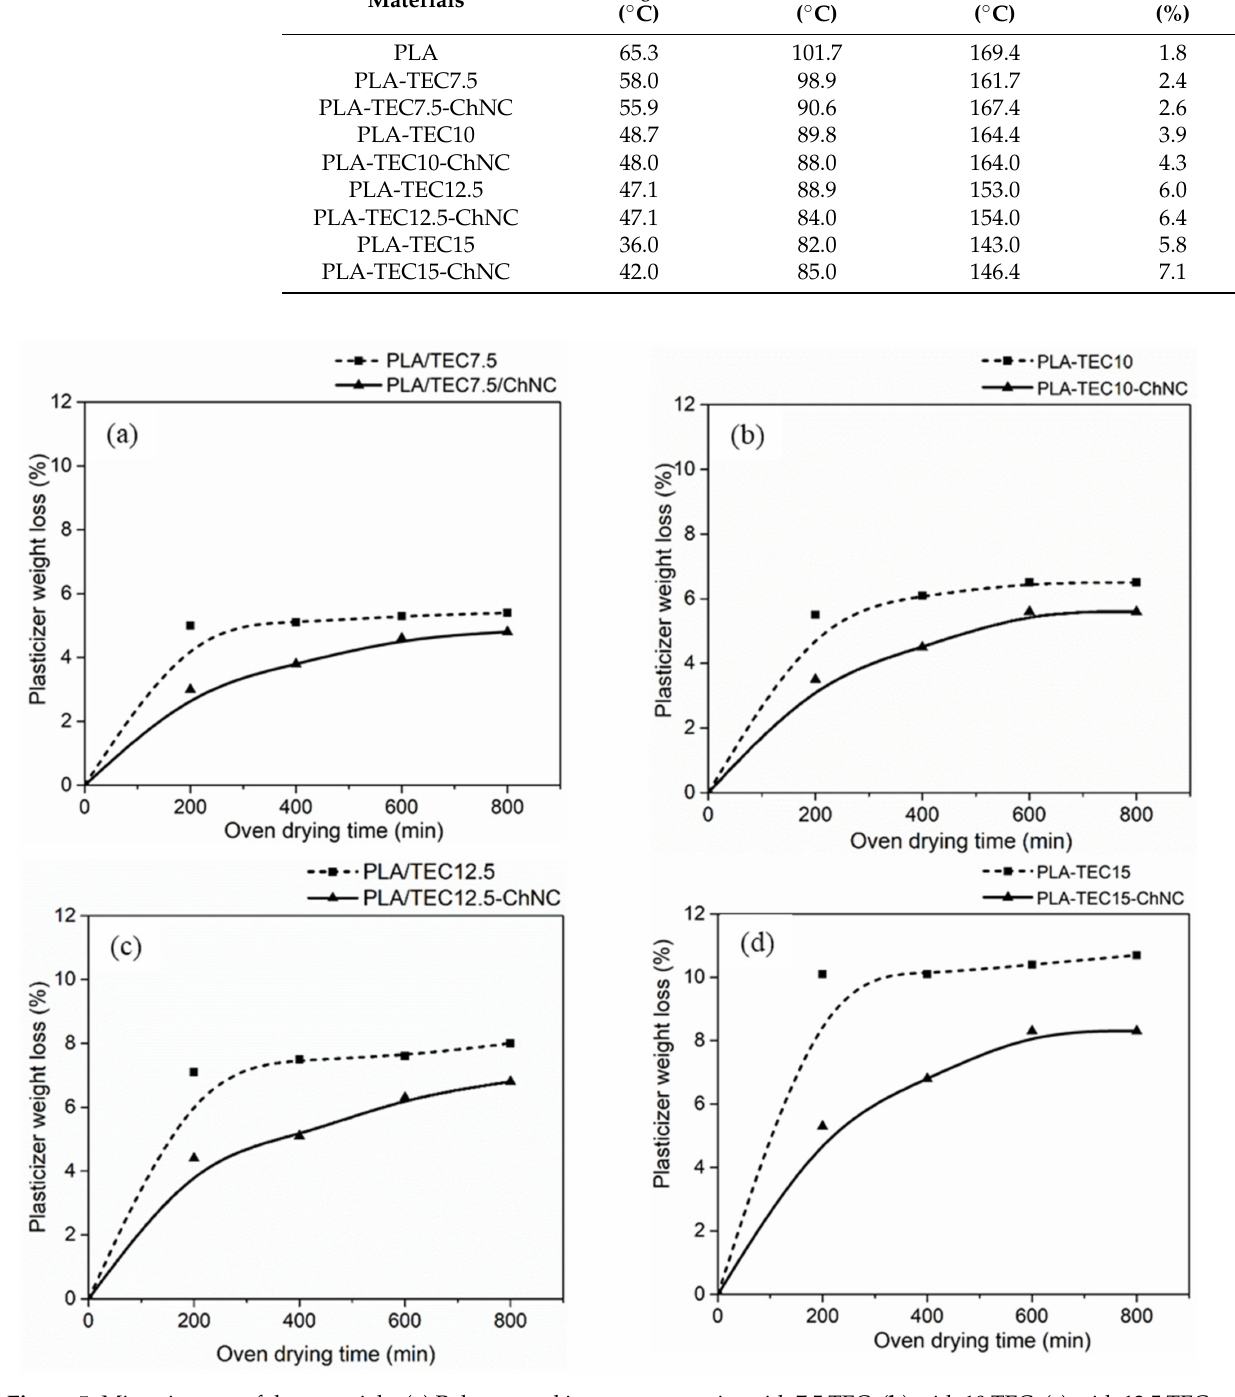
Figure 5. Migration test of the materials. ( a ) Polymer and its nanocomposite with 7.5 TEC, ( b ) with 10 TEC, ( c ) with 12.5 TEC and ( d ) with 15 TEC showing the effect of ChNC dispersion on the migration of